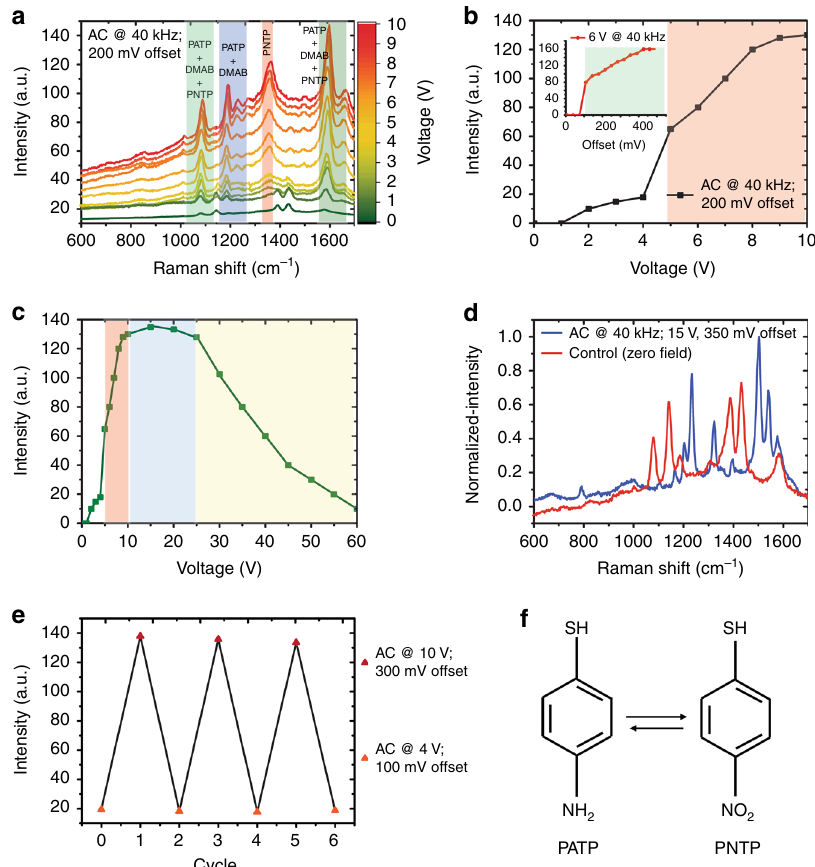
Fig. 2 In fl uence of applied electric fi eld on the SERS spectra of PATP on the template. a SERS measurements of PATP on the FF-PNT/Ag NP template at different electric fi elds strengths, applying voltages from 0 – 10 V at 40 kHz AC with offset DC bias of 200 mV. b , c Corresponding Raman band intensity at 1334 cm − 1 (assigned to PNTP) as a function of voltage. b Critical threshold voltage ~4 V required for the formation of PNTP. Inset illustrates SERS intensity with offset DC bias. c The window of 10 – 20 V is optimal for PNTP product yield via photocatalysis, with SERS intensity reducing above ~25 V. d Normalized SERS spectra, comparing a fully relaxed control sample at zero fi eld (red) to the spectrum recorded with applied fi eld (blue). e Plot of SERS signal strength intensity vs. AC electric fi eld, showing manipulation of the product yield achieved by utilizing an electric fi eld with a voltage of 10 V and an offset DC bias of 300 mV (conditions that yield PNTP) vs. a weaker electric fi eld formed using a voltage of 4 V and an offset DC bias of 100 mV (conditions that yield PATP). f Schematic illustration of the transformation and switch of the product formation of PATP to